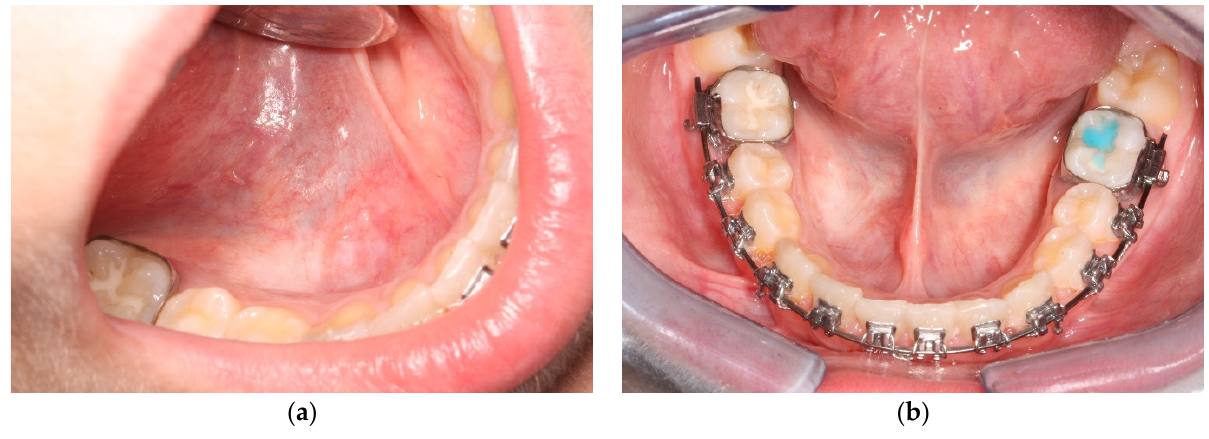
Figure 8. Intraoral clinical examination at 24 ‐ month follow ‐ up. Right side ( a ) and front view ( b